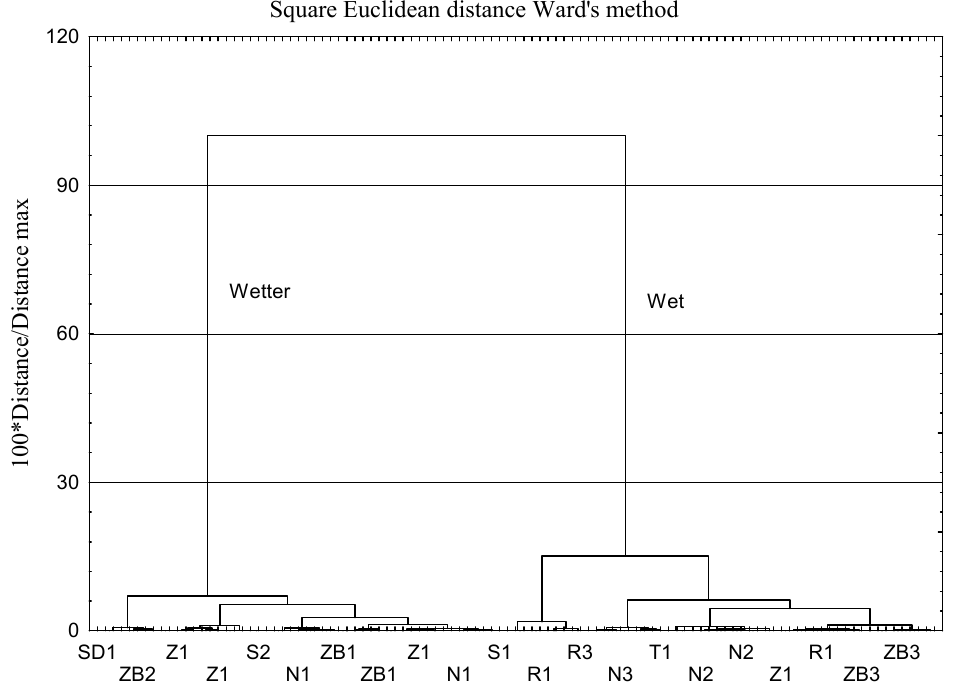
Figure 1. Dendrogram of cluster analysis on the basis of soils parameters. Abbreviations: wet (R1, R2, R3, ZB3, N2, N3 and SD2), wetter (S1, S2, T1, ZB1, ZB2, N1, SD1 and Z1), other abbreviations are as in Table 2.